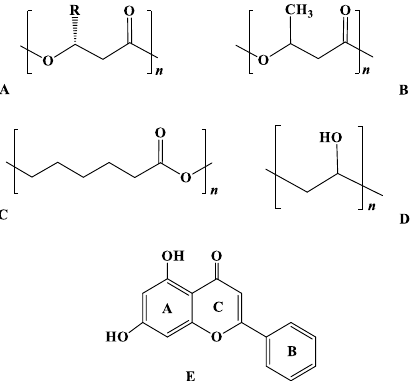
Figure 1. ( A ) General structure of PHAs, ( B ) structure of PHB, ( C ) structure of PCL, ( D ) structure of PVA, ( E ) structure of